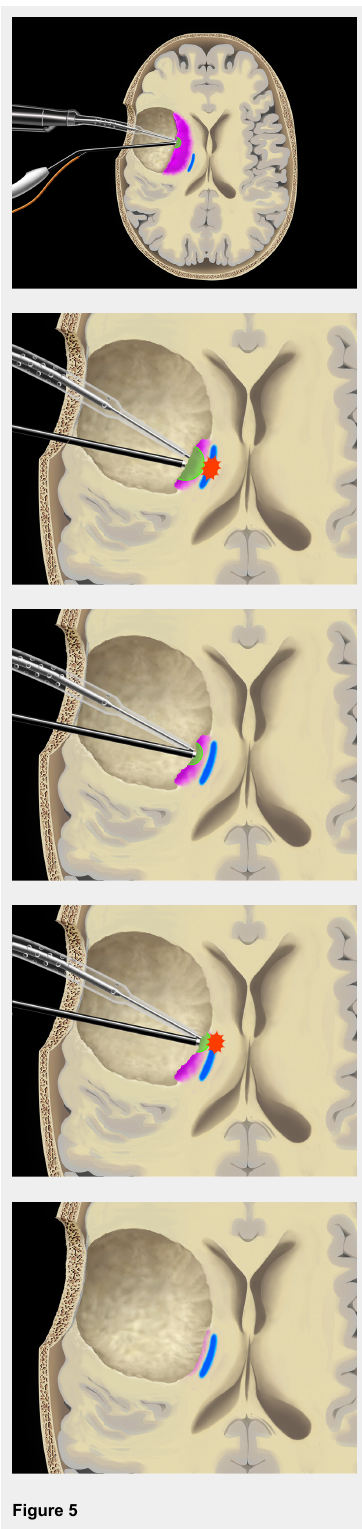
Use of the continuous dynamic mapping device. The continuous dynamic mapping device is used once the surgeon approaches the CST (A) . Resection is continued with an initial stimulation intensity of 10–15 mA (corresponding to a distance of 10–15 mm from the CST). The instant an MEP is elicited (B) , the surgeon is alerted by the change of the high-pitch negative control sound to a low-pitch alert sound. The stimulation intensity is then reduced by 2 mA, and the resection is continued at sites negative for the set current (C) , until again the acoustic switch from the negative control to the alert sound warns the surgeon that the MT has been reached (D) . This stepwise approach is continued until a minimal threshold is reached (E) . Pink indicates tumor tissue, blue indicates CST fibres, green indicates a region of active resection, and red indicates that an alert sound has occurred. Copyright Andreas Raabe. Published with